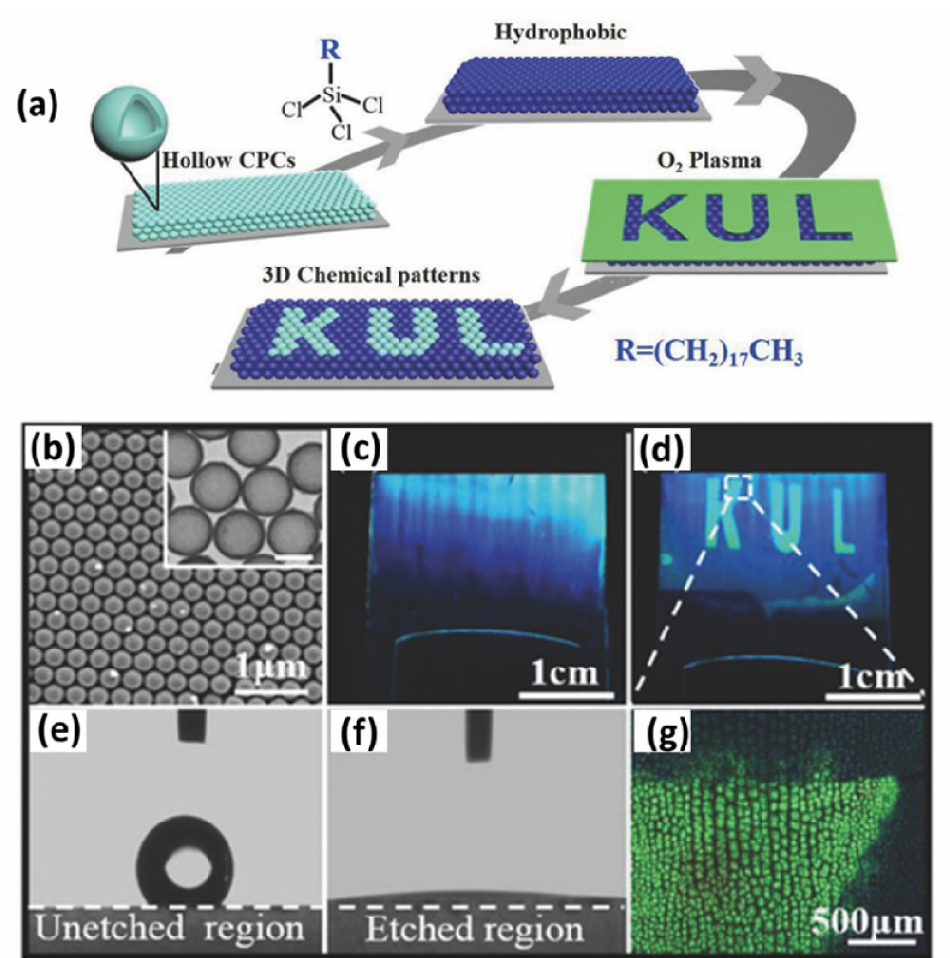
Figure 7. Invisible colloidal PC patterns shown by vapor. ( a ) Schematic illustration of the preparation procedure of the invisible PC pattern. ( b ) The SEM image of hollow PC. ( c ) The optical image of the invisible PC pattern under normal circumstances. ( d ) The pattern revealed by water vapor flow. ( g ) The microscopic image of the pattern that has been revealed. ( e – f ) Microscopic images of the water drop deposited on the unetched region ( e ) and O 2 plasma-etched regions ( f ) of the photonic print. Reused with permission from Reference [66], Copyright 2018,